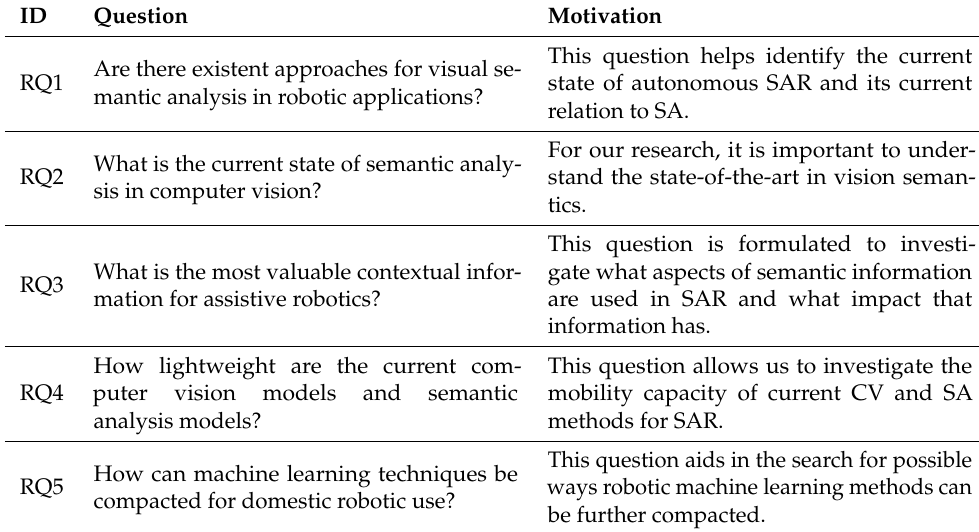
Table 1. Definitions of the research questions that helped mold the research and the points that we planned to study in relation to the state of the art.